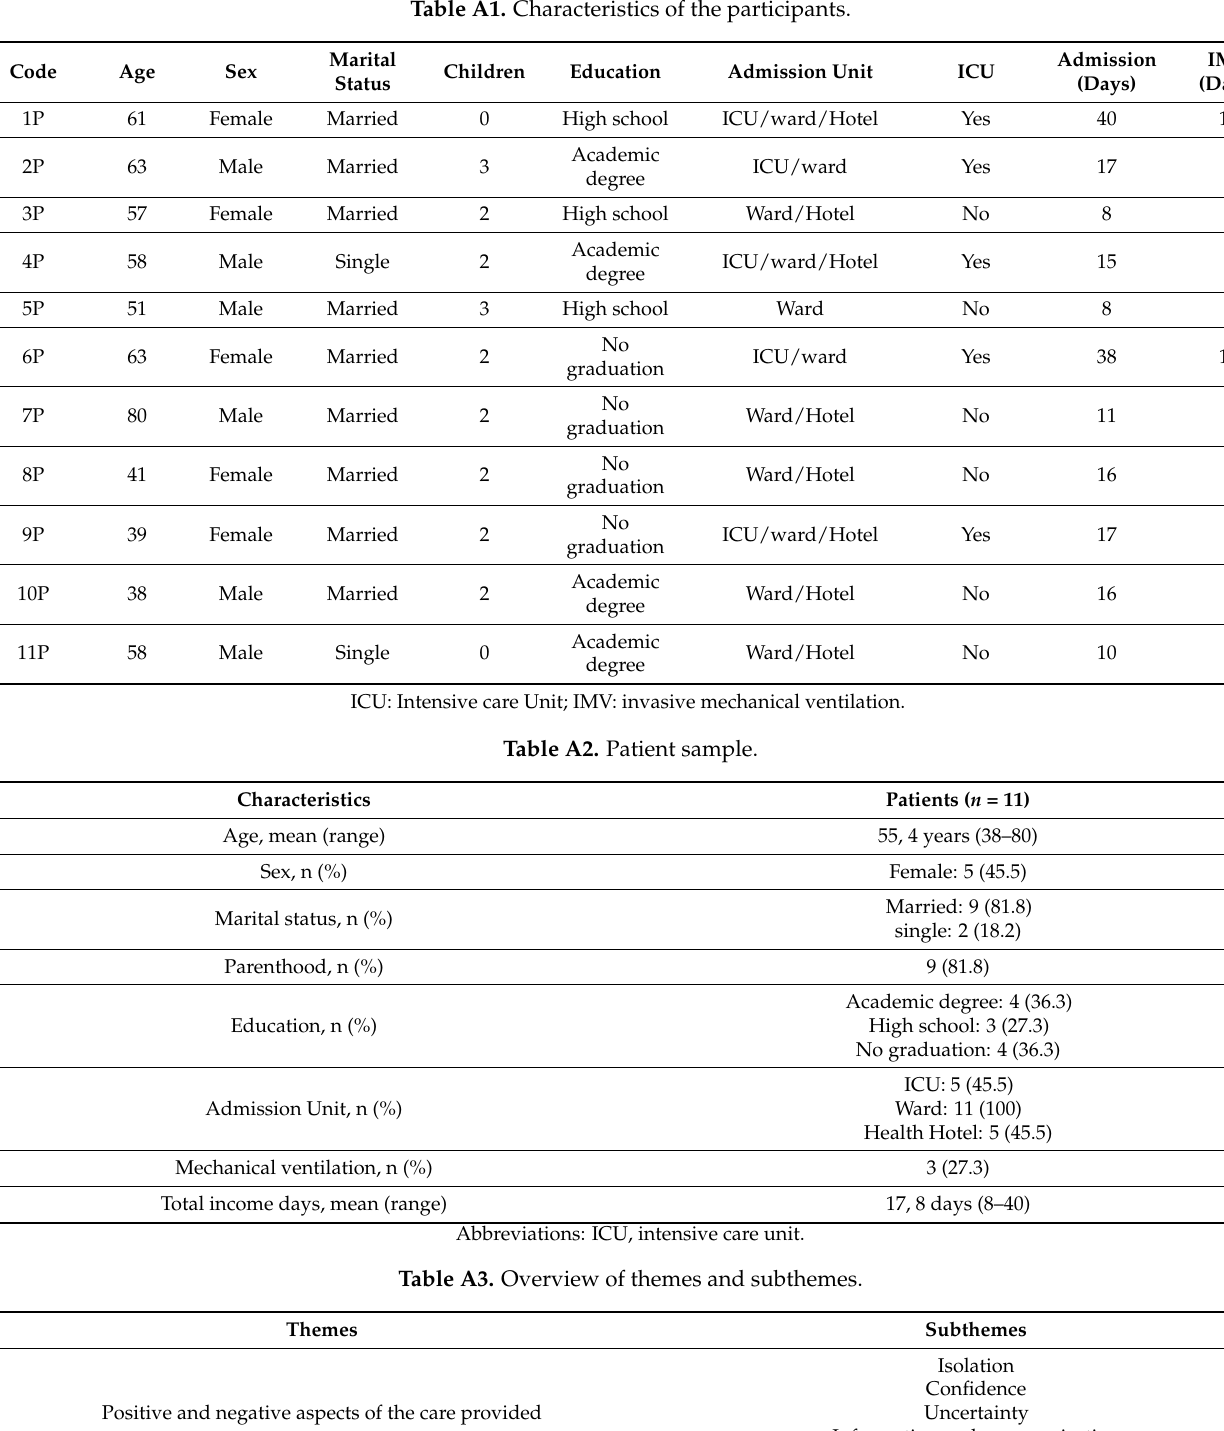
Table A1. Characteristics of the participants.